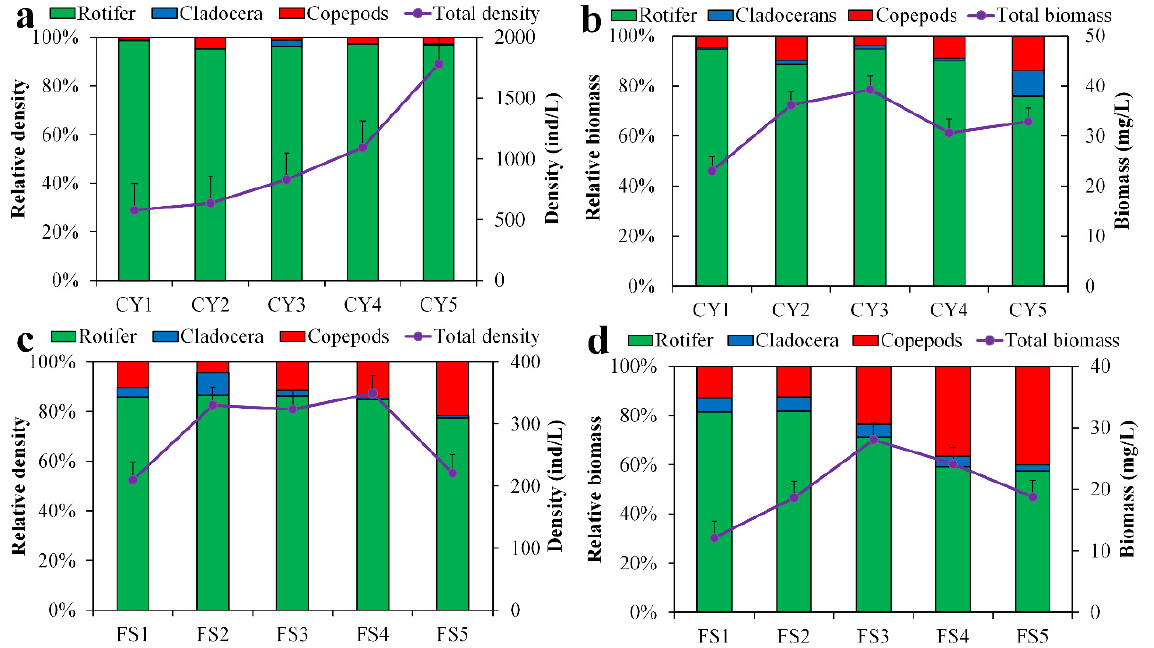
Figure 9. Spatial distribution of zooplankton biomass and density in Lake Chen Yao ( a , b ) and Lake Feng Sha ( c , d ).